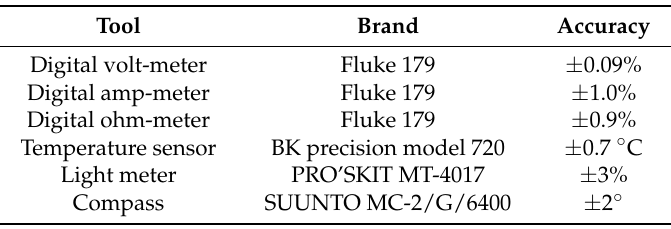
Table 2. Tools’ uncertainty.